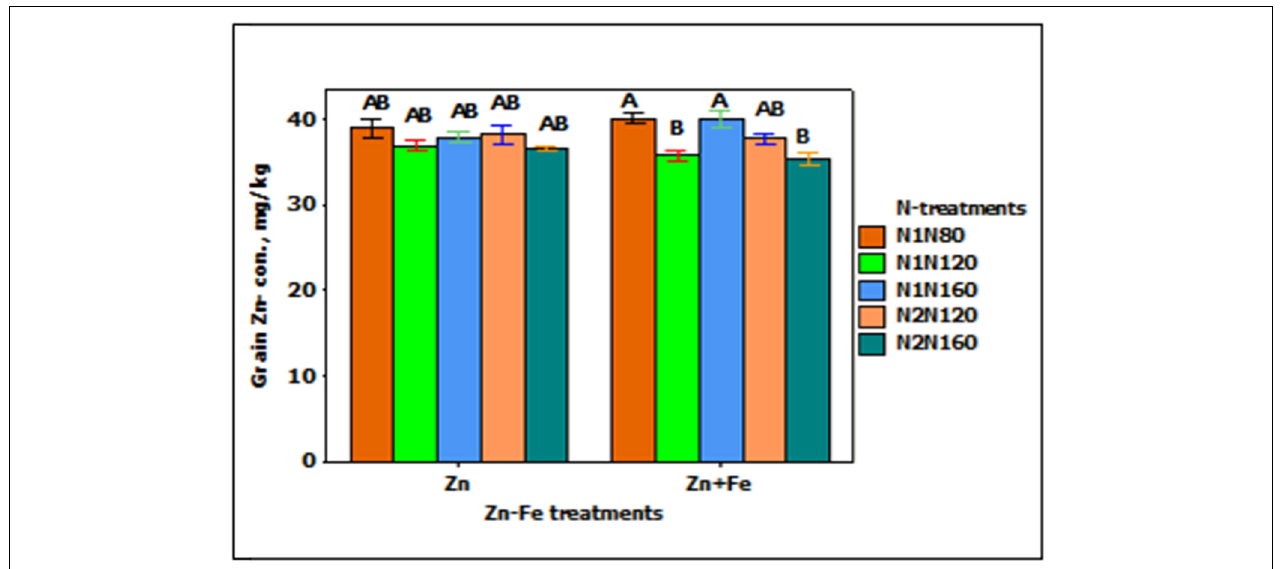
FIGURE 4 | Mean ± 1 SE ( n = 4) bar plot for the responses of grain Zn- concentration at N-treatments when Zn and Zn + Fe applied to growth media at sowing. N1 and N2 for single and split N. 80, 120, and 160 stand for rate of N in kg ha − 1 . Bars with same alphabet at head are not significantly different at 5% level of significance.